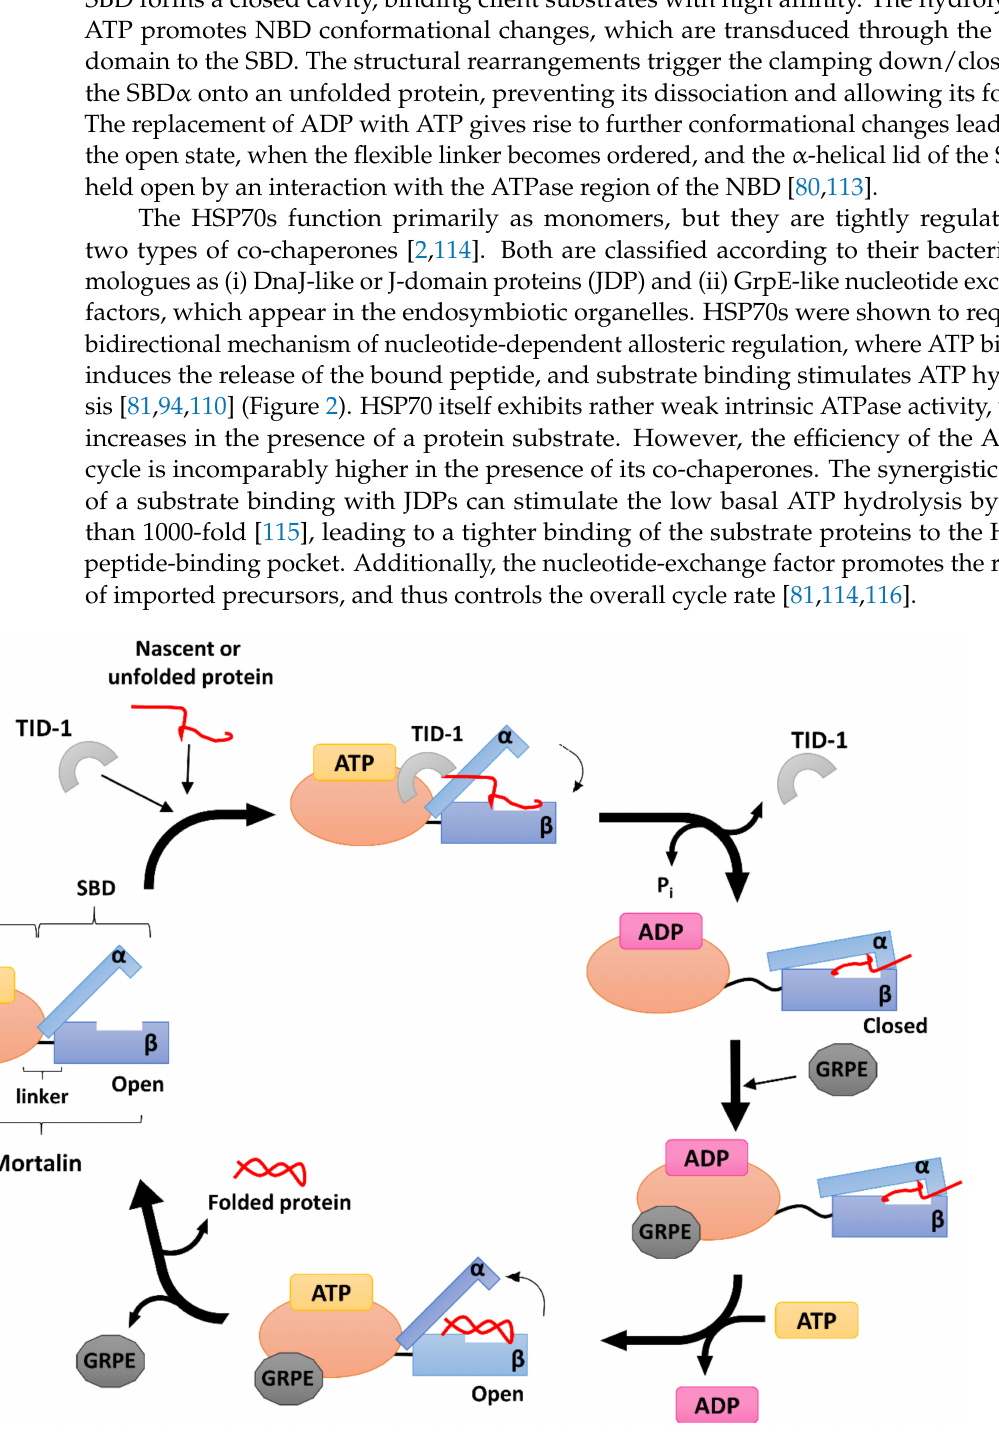
Figure 2. A likely model of the human mitochondrial HSP70 (mortalin) reaction cycle. Mortalin is composed of a nucleotide binding domain (NBD) and a substrate binding domain (SBD), which is divided into β and α sub-domains. The function of mortalin is tightly regulated by three co-chaperones, HEP1, TID-1 and either isoform of GRPEL1/2. HEP1 protects mortalin against self-aggregation and controls its ATPase activity. In the ATP-bound state, mortalin is in an open conformation and the flexible linker (located between the NBD and SBD) binds closer to the NBD. TID-1, which binds directly to mortalin, stimulates its ATPase activity, and prevents substrate protein aggregation. Substrate binding to the mortalin SBD binding cavity induces ATP hydrolysis and mortalin shifts into a closed conformation. GRPEL1/2 subsequently assists in the exchange of ADP for ATP. After ATP binding, mortalin returns into the open conformation and a folded substrate is